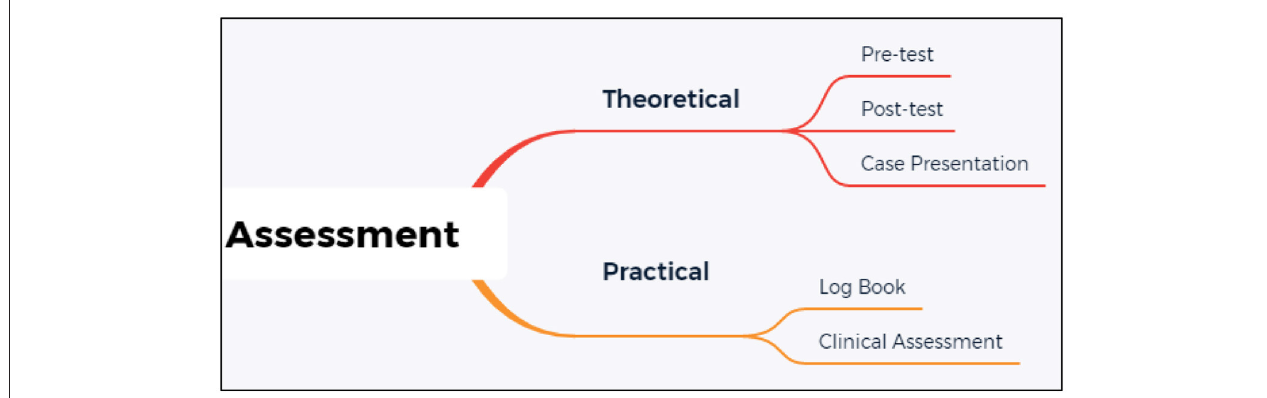
FIGURE 1 | Assessment